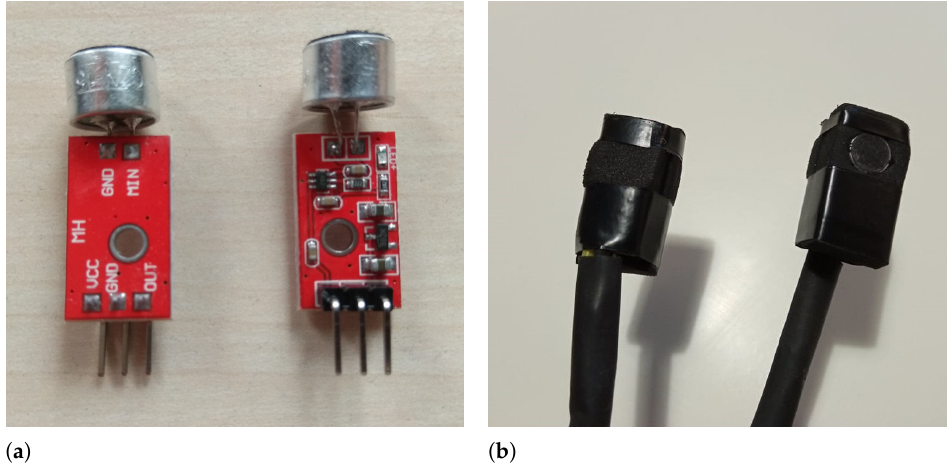
Figure 1. The microphone used in the project. ( a ) without protective coat; ( b ) with protective coat. Figure 2 shows the constructed device. Sound cards and battery basket are inserted into pockets in the elastic band.